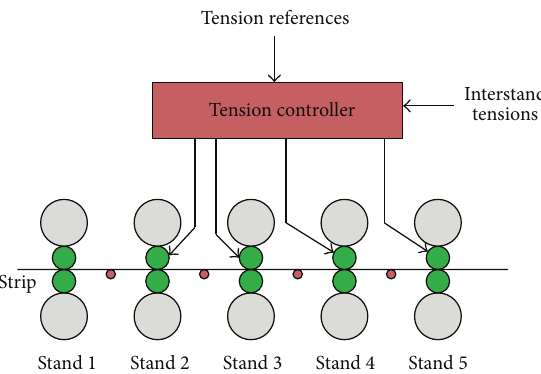
Figure 2: The structure of the advanced tension control